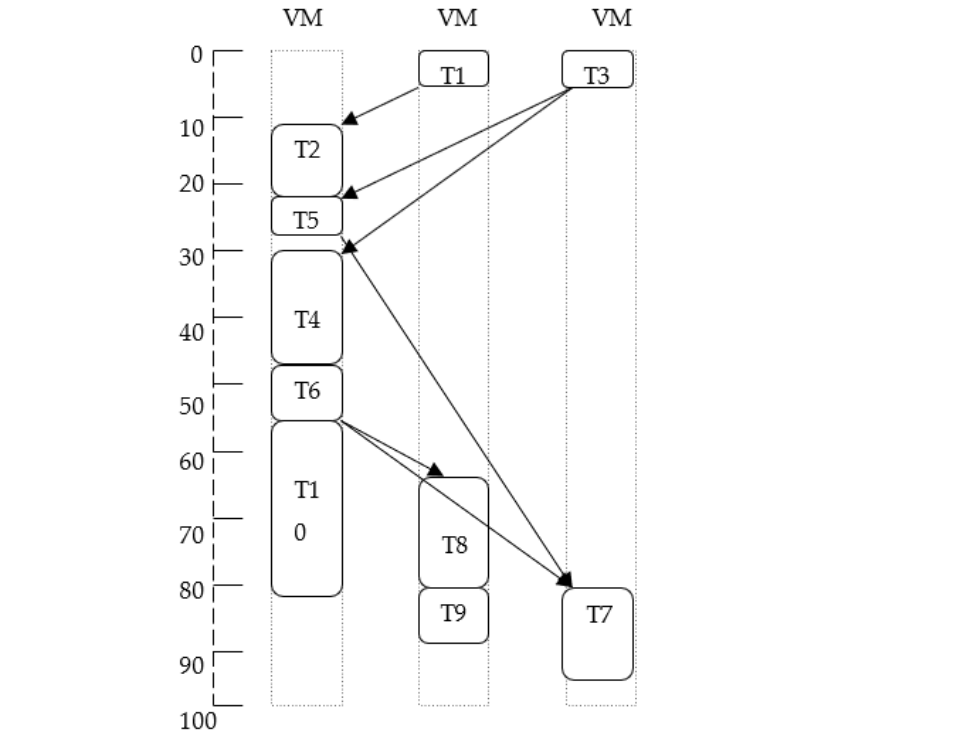
Figure 4. Scheduling of DAG with original HEFT algorithm (use of average computation cost in rank calculation). The schedule length is 98.